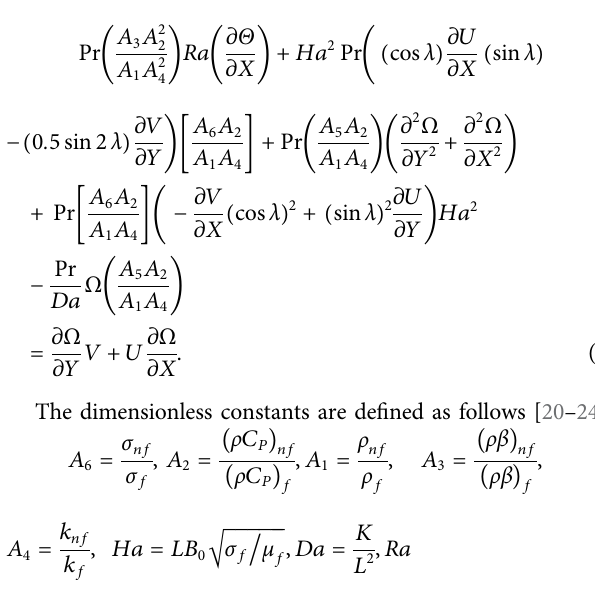
FIGURE 2 | Code veri fi cation according to